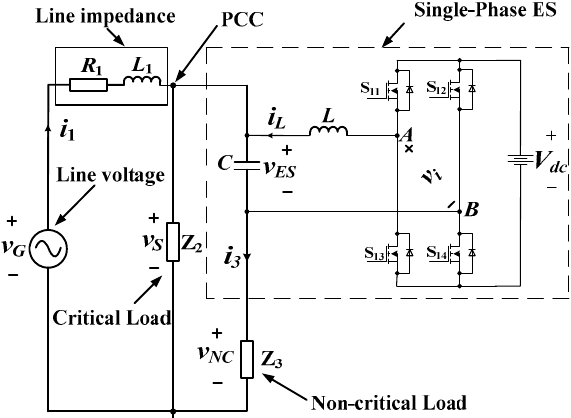
Figure 1. The typical topology of a single-phase ES embedded in a power system. ES: electric springs; PCC: point of common coupling.